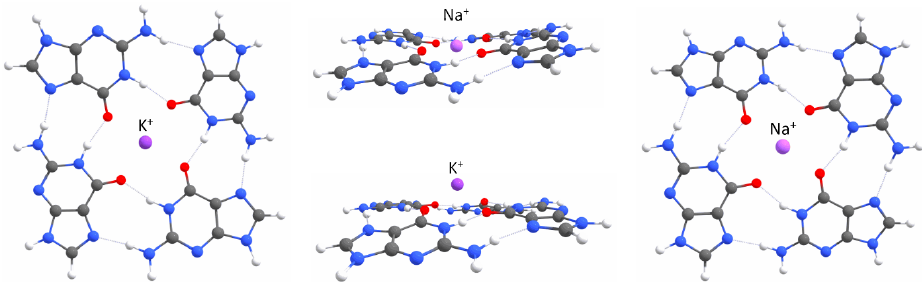
Figure 2. G-tetrads stabilized by potassium ( left ) and sodium ( right ) ions, calculated at the QM level of theory. The central panel presents different positions of K + and Na + cations with respect to the plane of